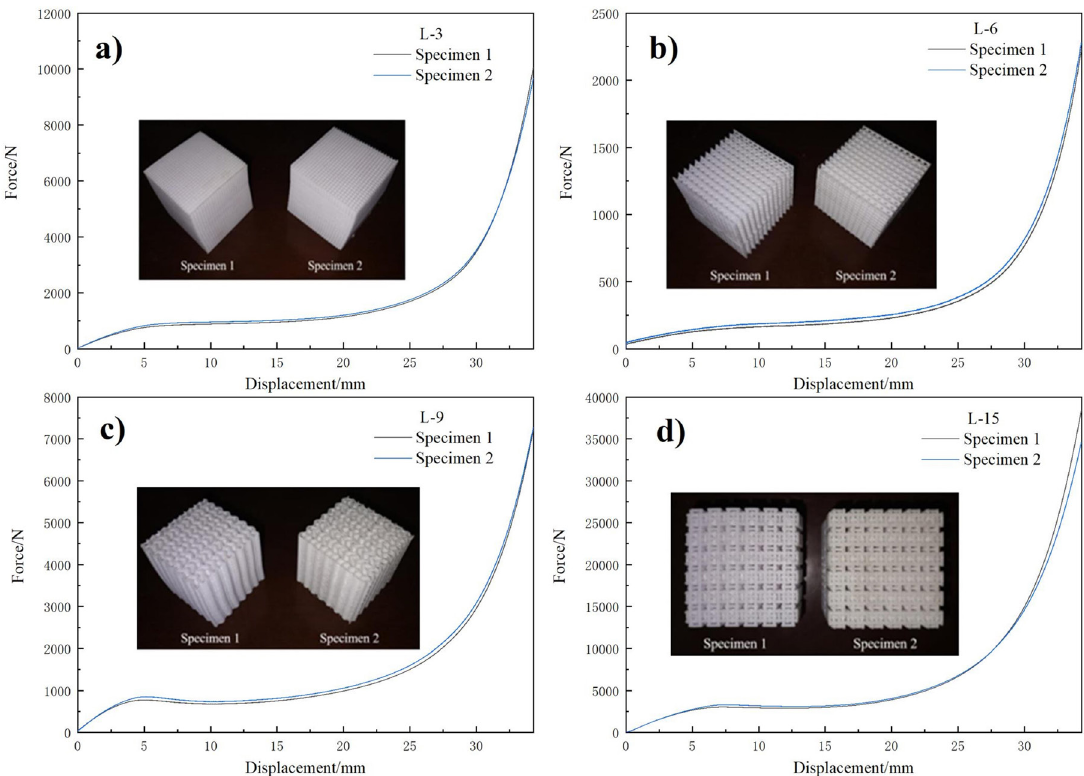
Figure 4. Experimental force-displacement curves of several representative structures: a) L-3, b) L-6, c) L-9, d)